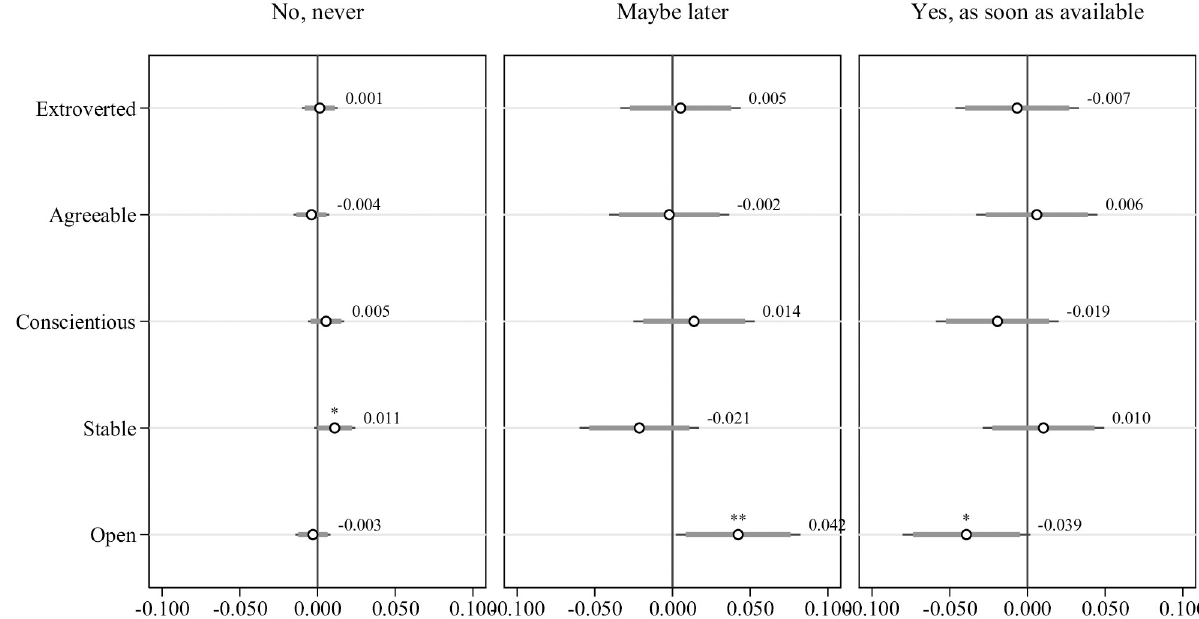
Fig 6. Multinomial probit regressions: Willingness to get vaccinated and Big-5 personality traits, controlling for individual and situational characteristics, and preferences. Dependent variable is willingness to get vaccinated. Individual characteristics include being female, being younger, education, being a healthcare worker, and being native. Situational factors include belonging to COVID-19 risk group, living with someone belonging to COVID-19 risk group, having had contact with a COVID-19 infected person outside work, having been outside Switzerland, using public transport and having had a positive test result of COVID-19 in the past. Preferences include the level of trust in strangers, risk aversion, patience, future orientation, altruism and reciprocity and the perceived percentage of people in the region wanting to get vaccinated. All regressions include hospital and time fixed effects. Standard errors in parentheses, n = 915. � p < 0.1, �� p < 0.05, ��� p < 0.01, ���� p <